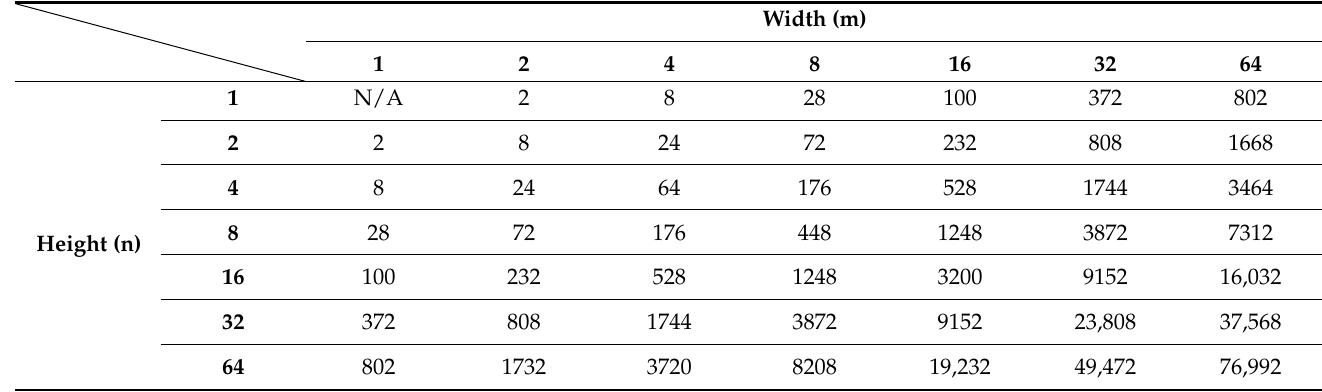
Table 3. The number of additions when the horizontal and vertical transforms are both DCT-II in the